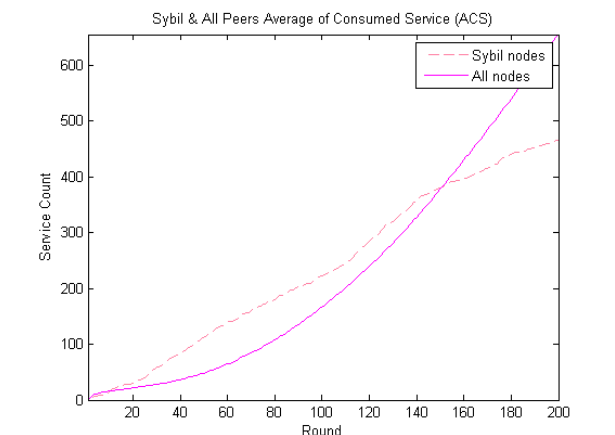
Figure 5. Identifying Sybil nodes.